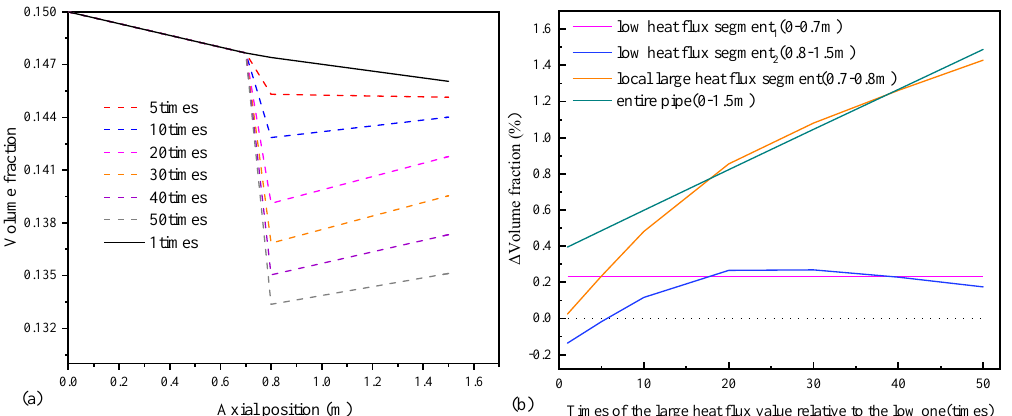
Figure 11. ( a ) Axial evolution of IVF ( b ) ΔIVF of each segment at different multiples of local large heat flux section.